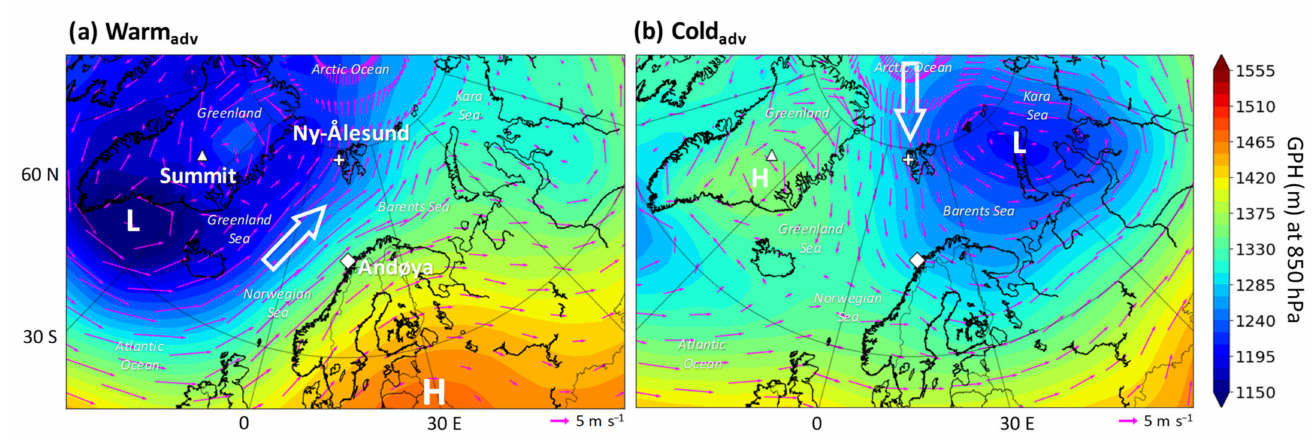
Figure 4. Mean geopotential height (GPH) and wind fields at 850 hPa pressure level (ERA5 reanalysis data) for ( a ) warm adv and ( b ) cold adv cases. Locations of Ny-Ålesund, Andøya, and Summit are denoted with “crosshair,” “diamond,” and “triangle” symbols, respectively. White arrow represents the dominant wind direction around Ny-Ålesund during two periods. “L” and “H” denote the low-pressure system (cyclone) and high-pressure system (anticyclone),